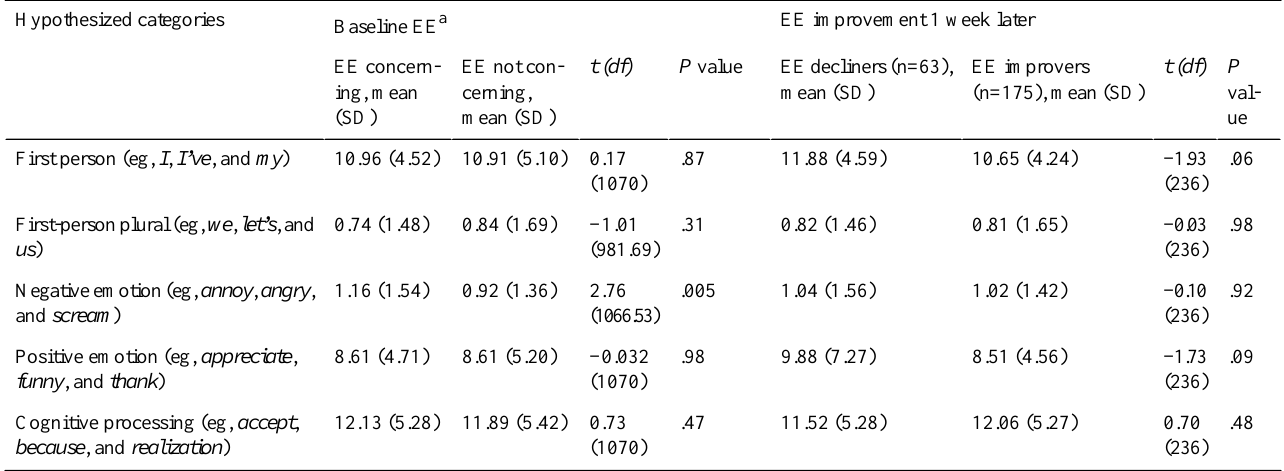
Table 6. Independent t tests of linguistic differences in gratitude letters by baseline emotional exhaustion (concerning or not) and emotional exhaustion improved (or declined) at the 1-week